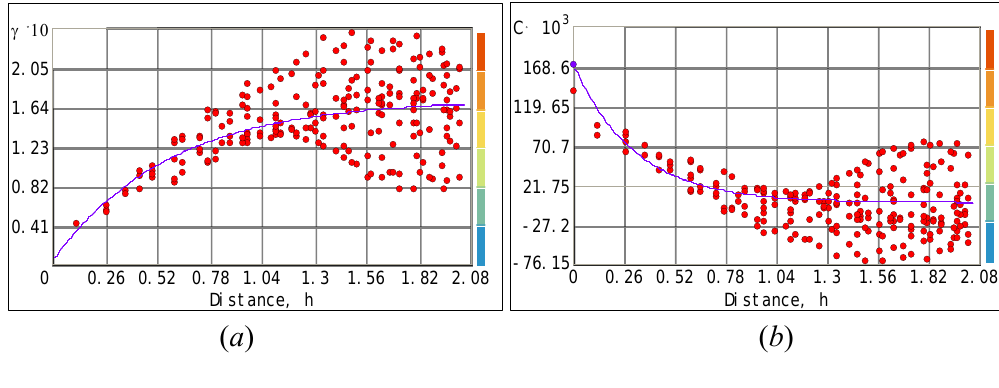
Figure 9. Fitting the spherical model to the experimental: ( a ) variogram and ( b ) covariance.